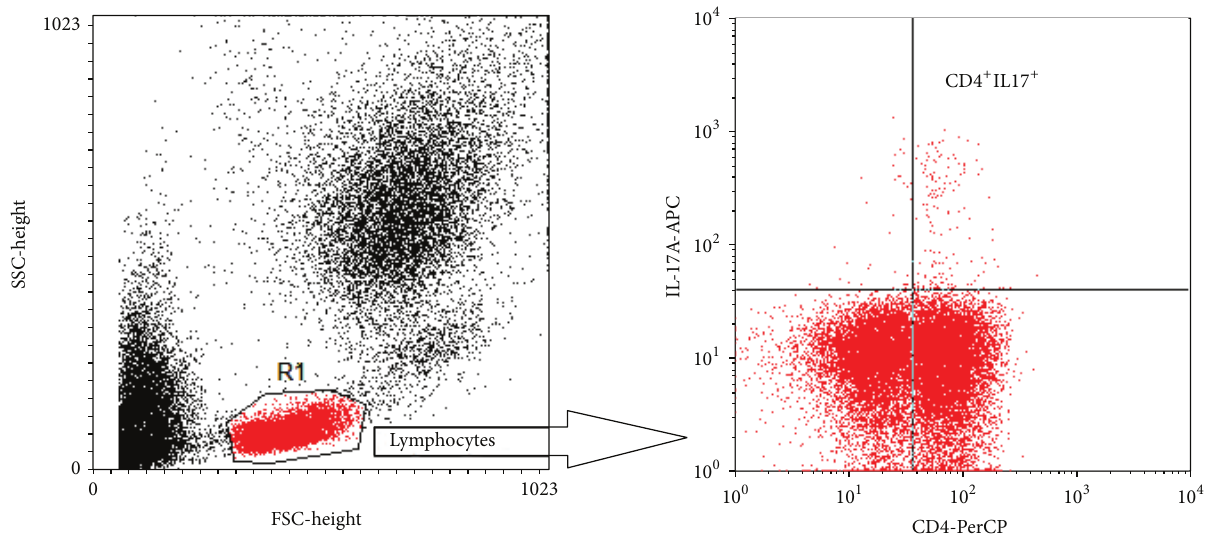
Figure 2: Representative dot plots. CD4 + IL-17A + positive cells were determined on CD4-PerCP versus IL-17A-APC dot plot by gating on lymphocyte on the forward-scatter versus side-scatter dot plot. Table 4: Distribution of CD8 + lymphocyte subpopulations in peripheral blood of pSS patients and controls. Patients 1